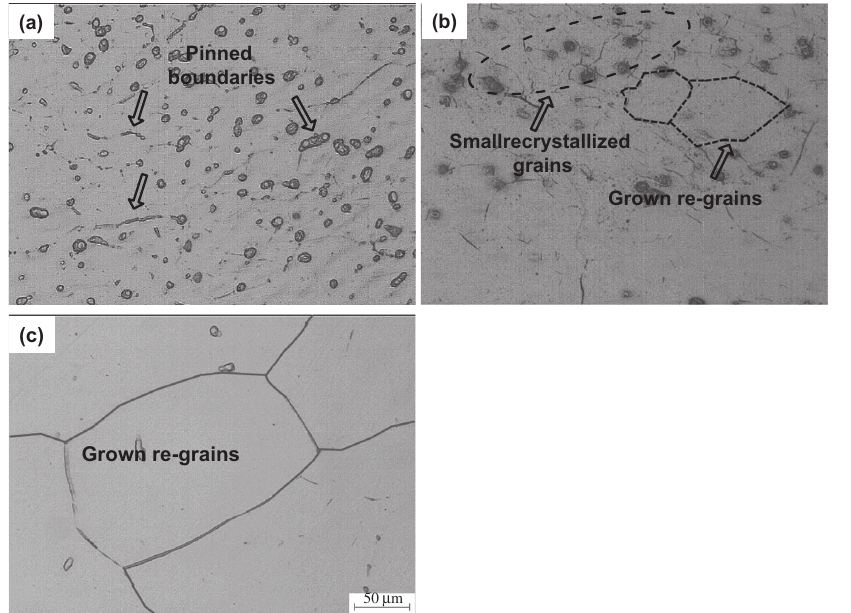
Figure 10: Microstructures of the specimens at the strain rate of 0.001 s − 1 and the temperatures of (a) 950°C, (b) 1,010°C and (c) 1,050°C, which reveal the effect of second-phase particles on the growing process of